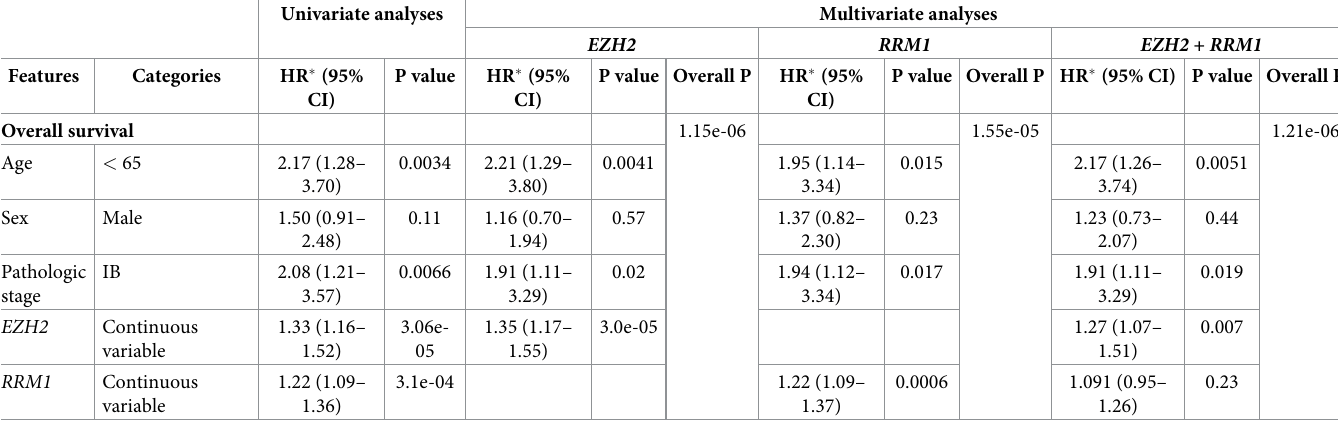
Patients were dichotomized into two groups based on the median value of gene expression of RRM1 and EZH2 . In univariate analysis, patients with high expression levels of RRM1 and EZH2 had significantly lower OS ( RRM1 Kaplan-Meier log-rank p = 5.9e-04, HR = 2.47, 95% CI = 1.45–4.20; EZH2 Kaplan-Meier log-rank p = 3.2e-02, HR = 1.74, 95% CI = 1.04–2.90) ( Fig 3A and 3B ) and lower DFS ( RRM1 Kaplan-Meier log-rank p = 9.1e-02, HR = 1.60, 95% CI = 0.92–2.78; EZH2 Kaplan-Meier log-rank p = 4.1e-03, HR = 2.25, 95% CI = 1.27–3.98). In